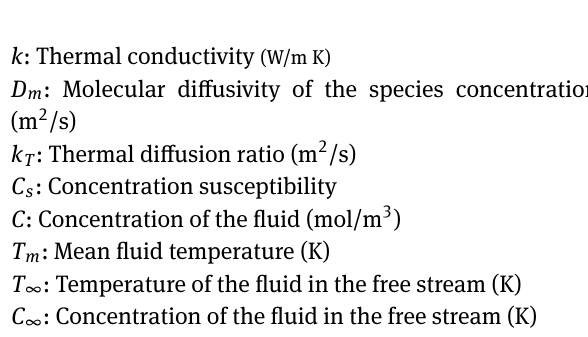
Fig. 9: Influence of Sr on concentration field Fig. 10: Influence of Du on temperature